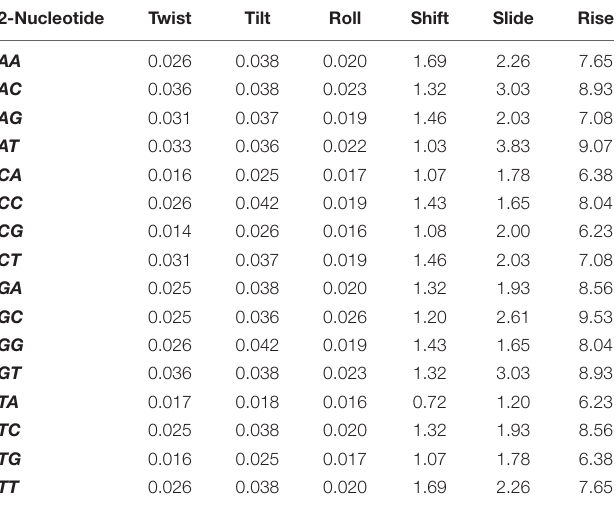
TABLE 1 | Six physical structural properties and its